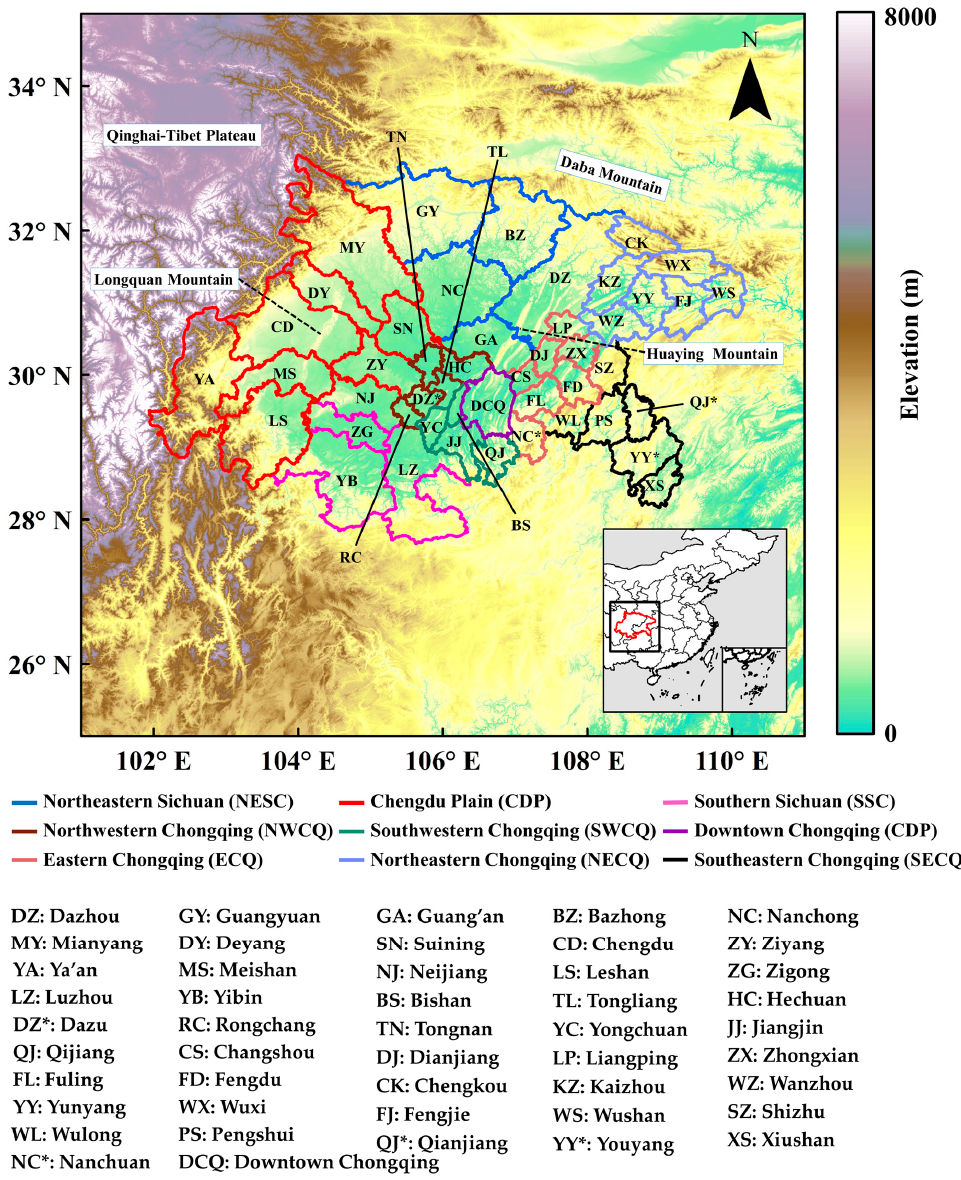
Figure 1. The administrative divisions and urban agglomerations in SCB. The background shadings represent the topography of this region. The black square and the red polyline in the inner subplot are the domain of the dispersion simulation and the location of SCB, respectively. The asterisks are used to distinguish the cities with the same abbreviation.